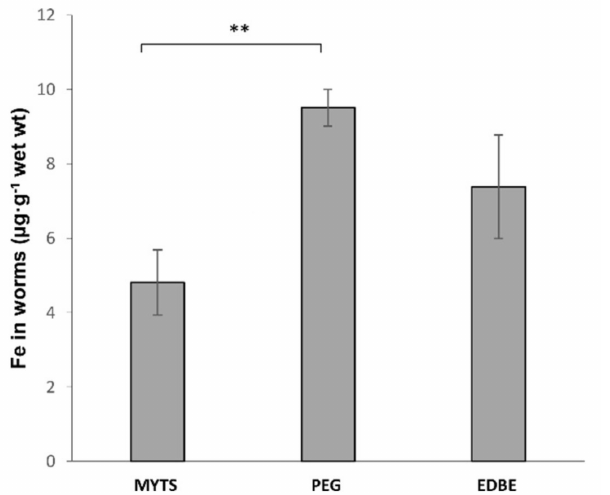
Figure 4. GFASS analysis of iron NPs accumulation in C. elegans . Synchronized worms ( n ~3000) were treated with 100 µ g/mL of unconjugated MYTS, MYTS-PEG or MYTS-EDBE and incubated for 30 h at 20 ◦ C. Each value was obtained by subtracting the value of the control sample (incubated with no addition). Data are expressed as the mean of three independent experiments ± standard error (SE). ** p < 0.01 vs. MYTS was calculated by Student’s t